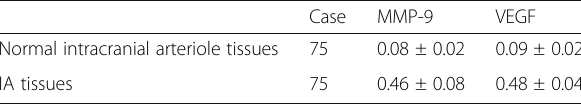
Table 4 Expression of MMP-9 and VEGF in normal intracranial arterioles tissues and IA tissues